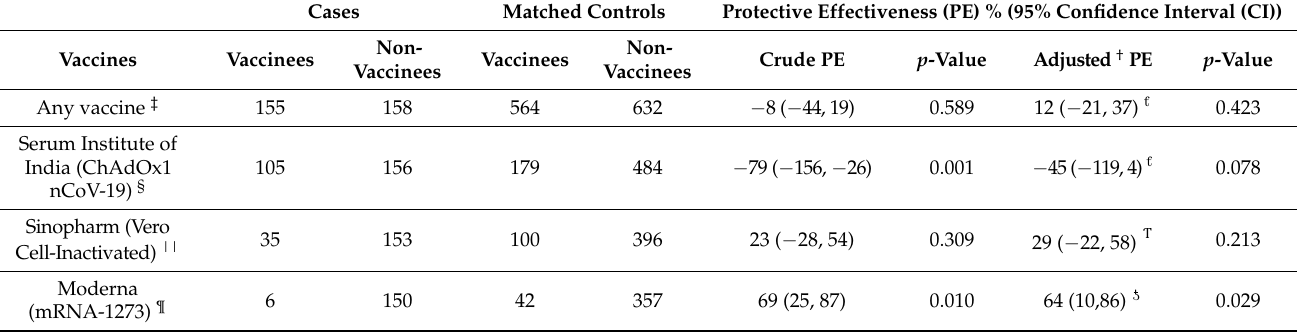
model: ƭ study month, gender, religion, household size, and household income. Ƭ Body mass index and smoking status. ƾ Gender and smoking status. ‡ Any vaccine (Serum Institute of India (ChAdOx1